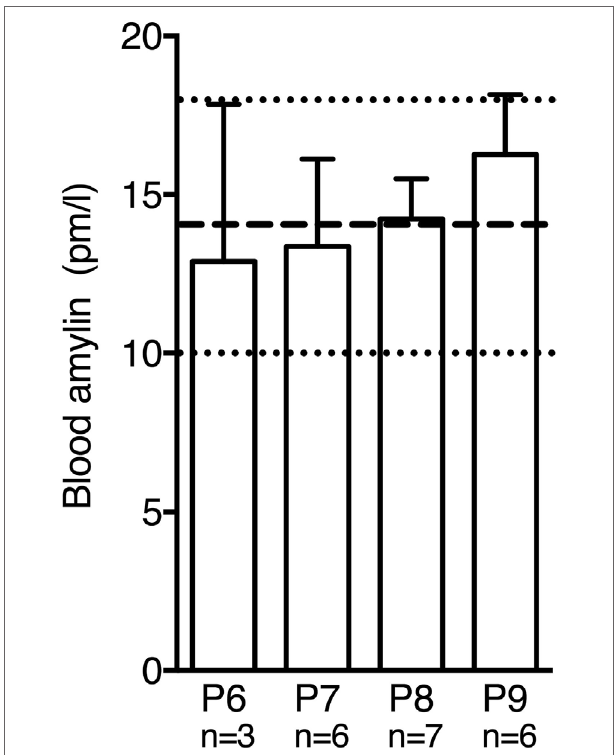
FigUre 4 | Postnatal amylin plasma levels in wild-type mice did not differ significantly between P6 and P9. During this time window amylin levels were similar to values reported for adult mice [dashed line and dotted lines represent mean ± SEM reported in Ref.